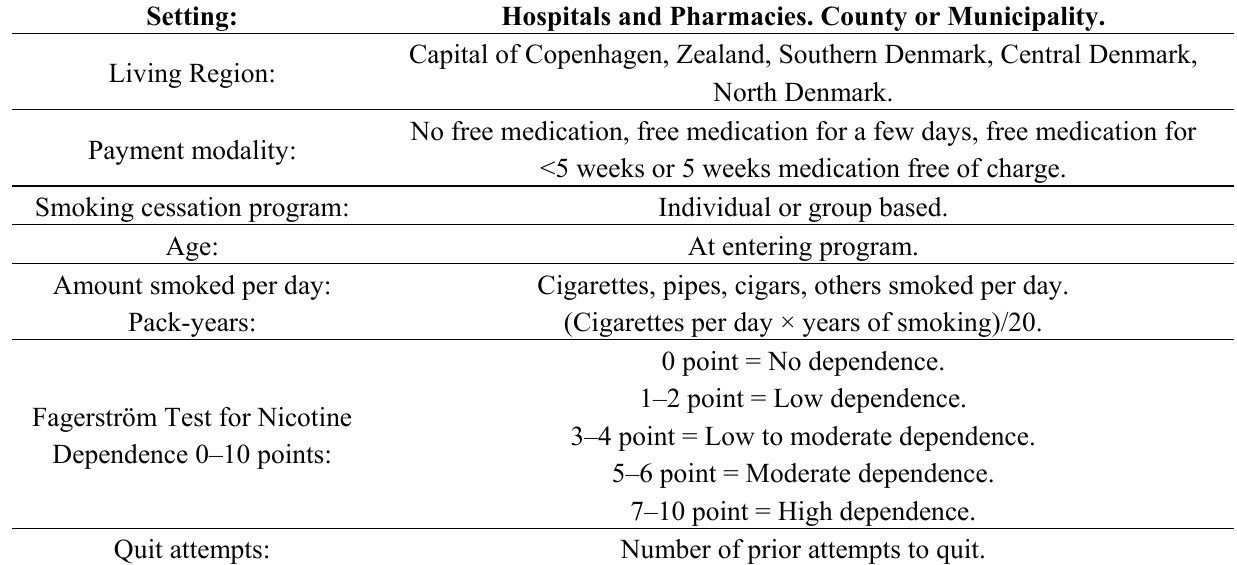
Figure 1. Flow-chart for the study population according to definition of age and responders vs. non-responders. * Validated data: doublets and non-existing personal identification number are excluded. Table 1. Data collected by the Danish Smoking Cessation